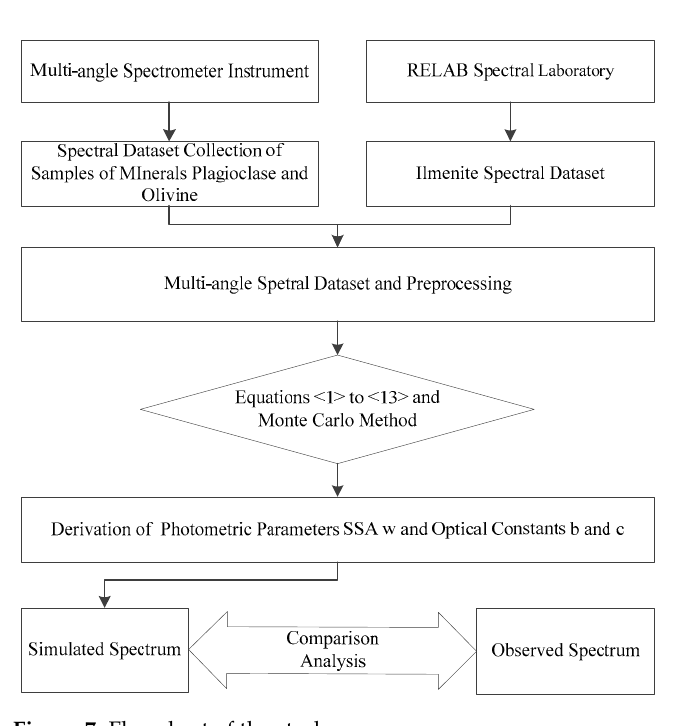
Figure 7. Flowchart of the study.